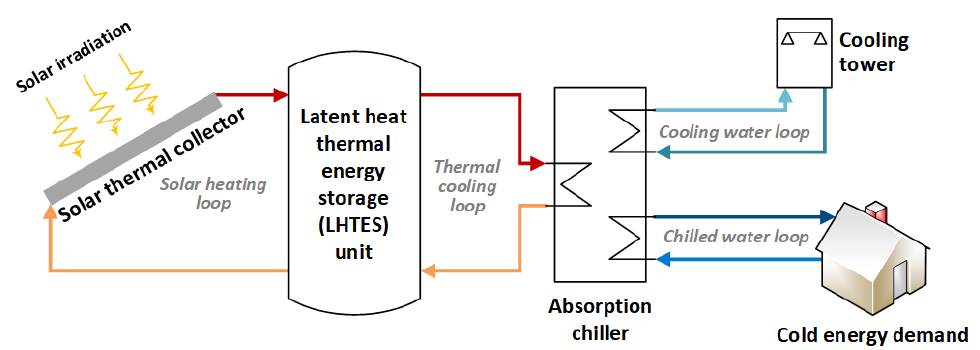
Figure 5. The layout of the solar-absorption cooling system.